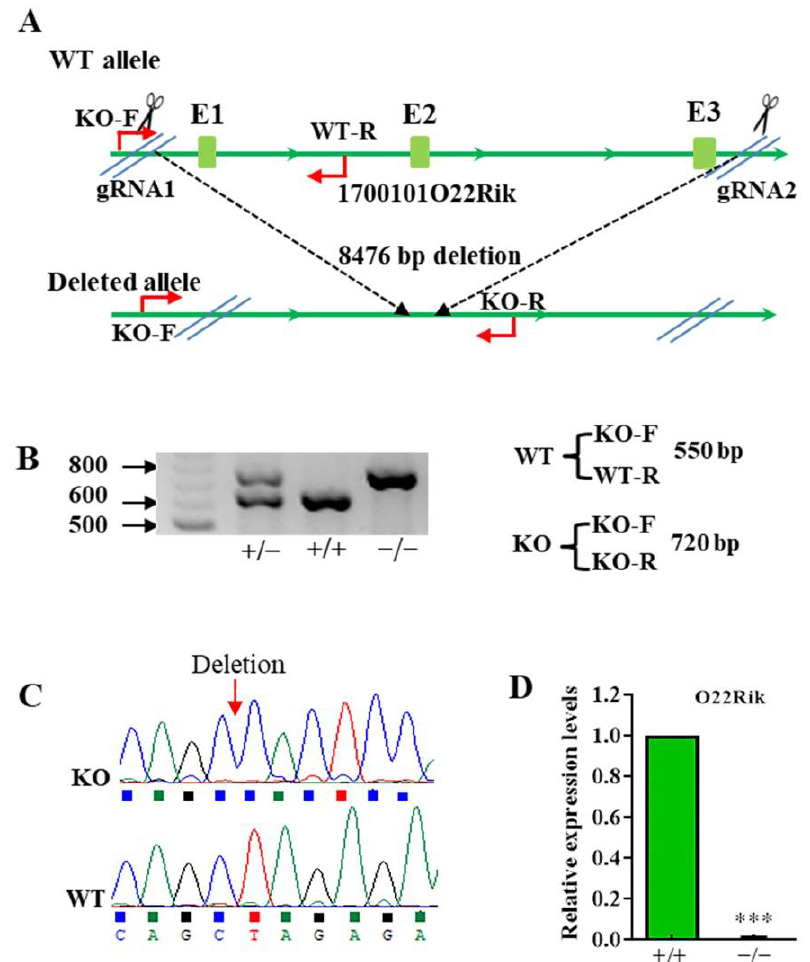
Figure 2. Construction and verification of gene knockout (KO) mice. ( A ) A schematic illustration of the Clustered Regularly Interspaced Short Palindromic Repeat (CRISPR)-Cas9-generated O22Rik KO mice. ( B ) The designed primers were used to identify the genotypes of KO mice. 720bp bands were identified in KO mice and 550 bp bands were detected in WT mice. ( C ) Sanger sequencing was performed using PCR products to verify the successful KO of gene fragment. ( D ) Validation of the O22Rik KO mouse model by qPCR. The O22Rik transcript was lost in KO mouse testes. Total RNA was isolated from the testis and the expression level of target gene was detected by qPCR. β -actin was also used as an internal reference gene to standardize gene expression. Data are the mean ± SEM ( n = 3). *** p < 0.001, compared with the group of